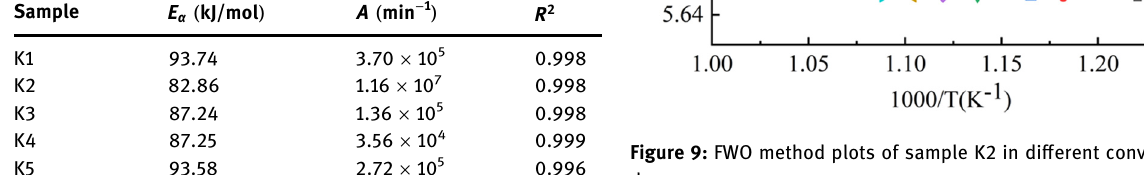
Table 3: Combustion kinetic parameters of di ff erent samples Sample